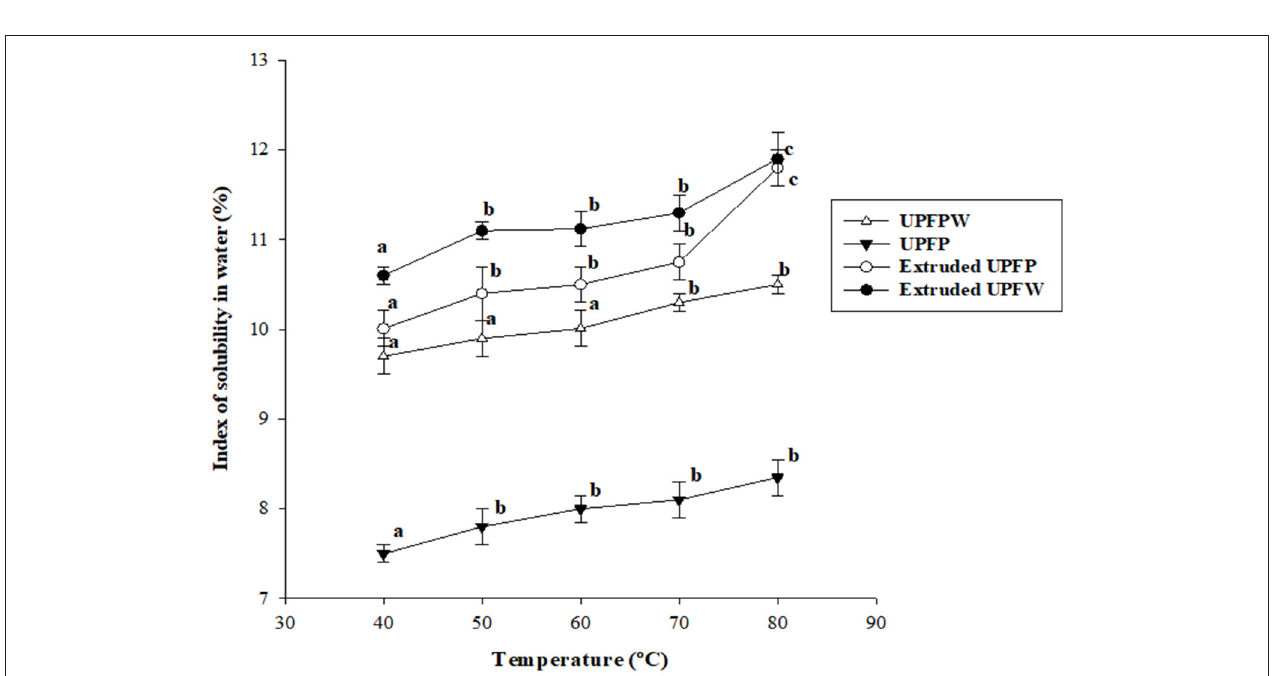
Frontiers in Nutrition |